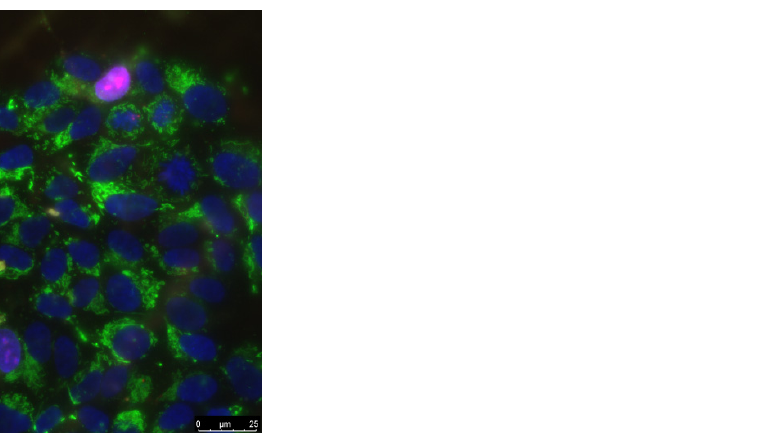
Figure 2. The sample of cell culture micrograph. The mitochondria of the cells are colored green and allow one to determine the size of cells. Normal cell nuclei are colored blue. Nuclei of non-viable cells are stained in purple.